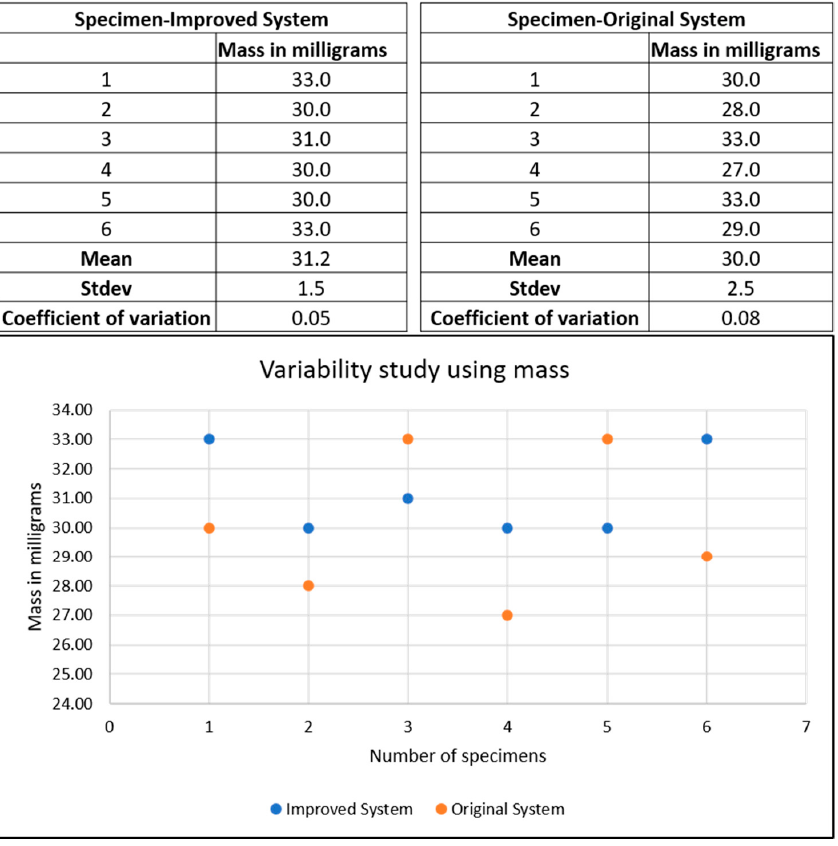
Table 1. Test matrix for the original and improved systems. Speed